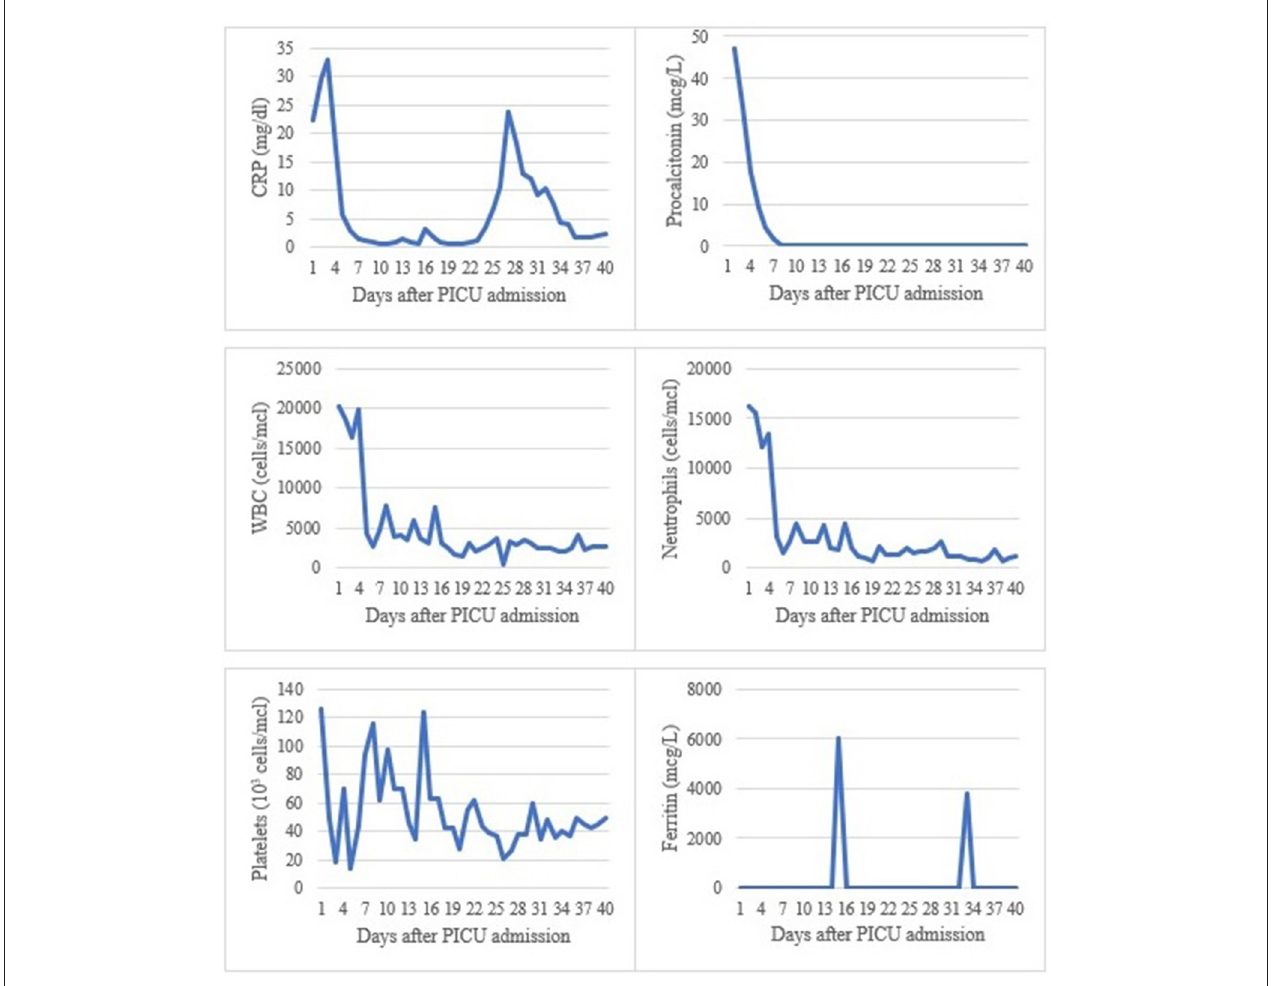
FIGURE 3 | Summary of blood analytical values during PICU stay. CRP, C reactive protein; WBC, white blood cell; PICU, pediatric intensive care